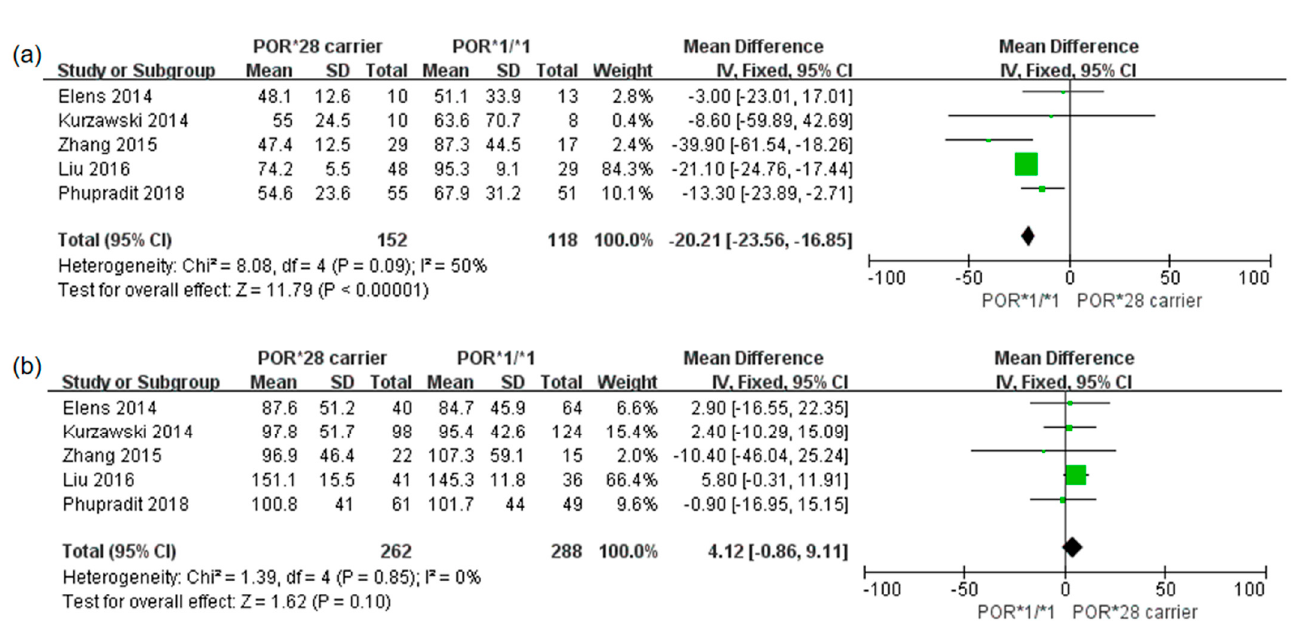
CI: confidence interval.